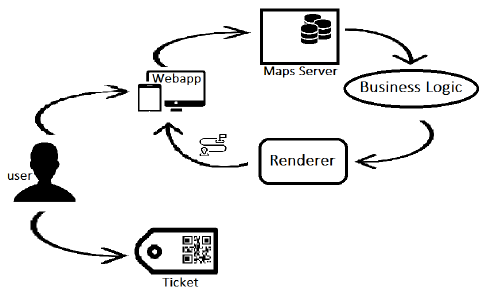
Figure 1. System